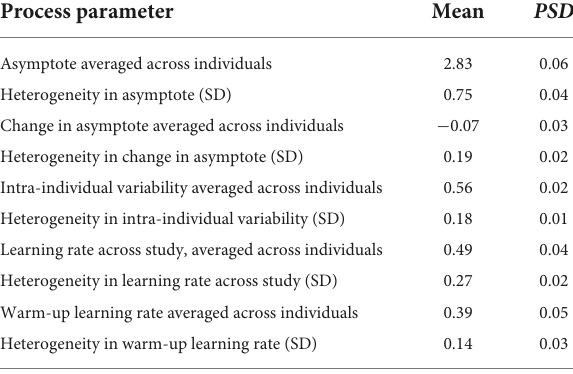
TABLE 1 Group-level (population) estimates of Bayesian double exponential model (BDEM) parameters based on data from the symbol search